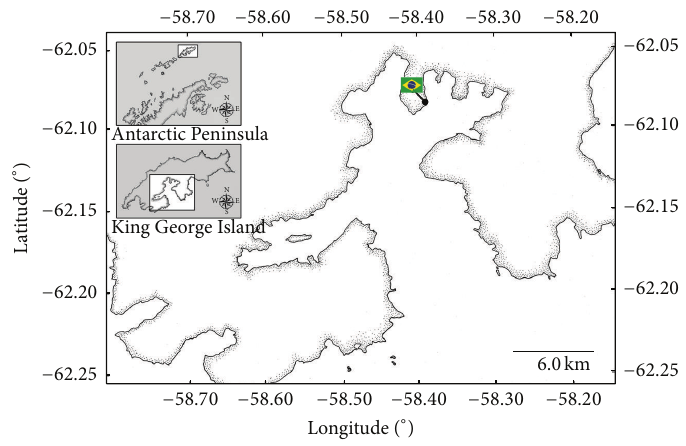
Figure 1: Geographical location of the EACF. Adapted from